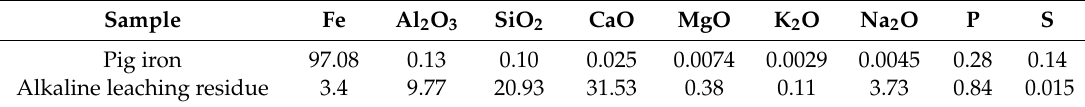
Table 9. Chemical compositions of pig iron and alkaline leaching tailing (wt.